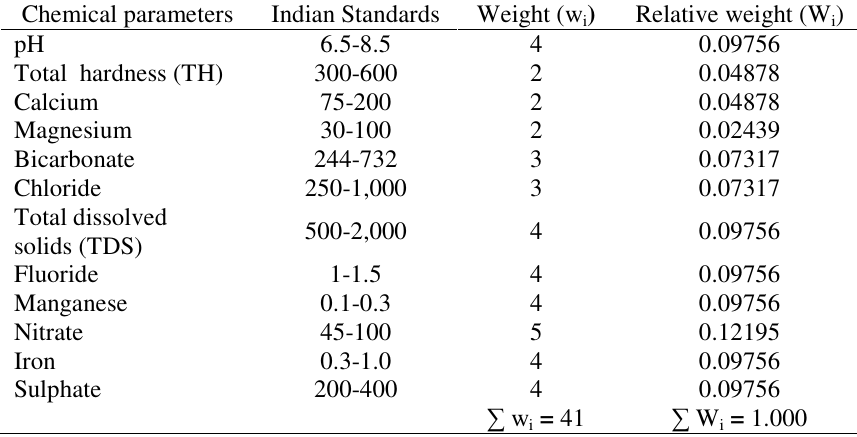
Table 3 . Relative weight of chemical